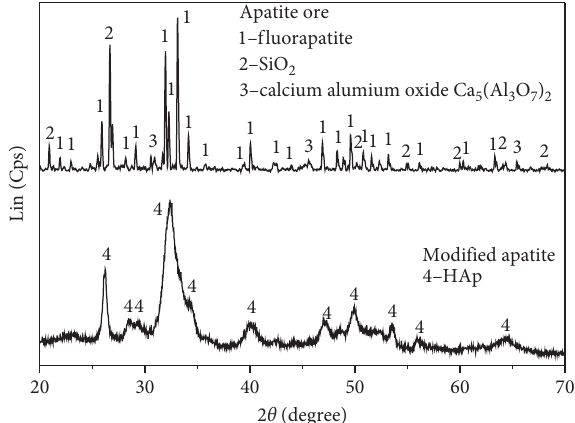
Figure 3: X-ray diffraction patterns of apatite ore before and after